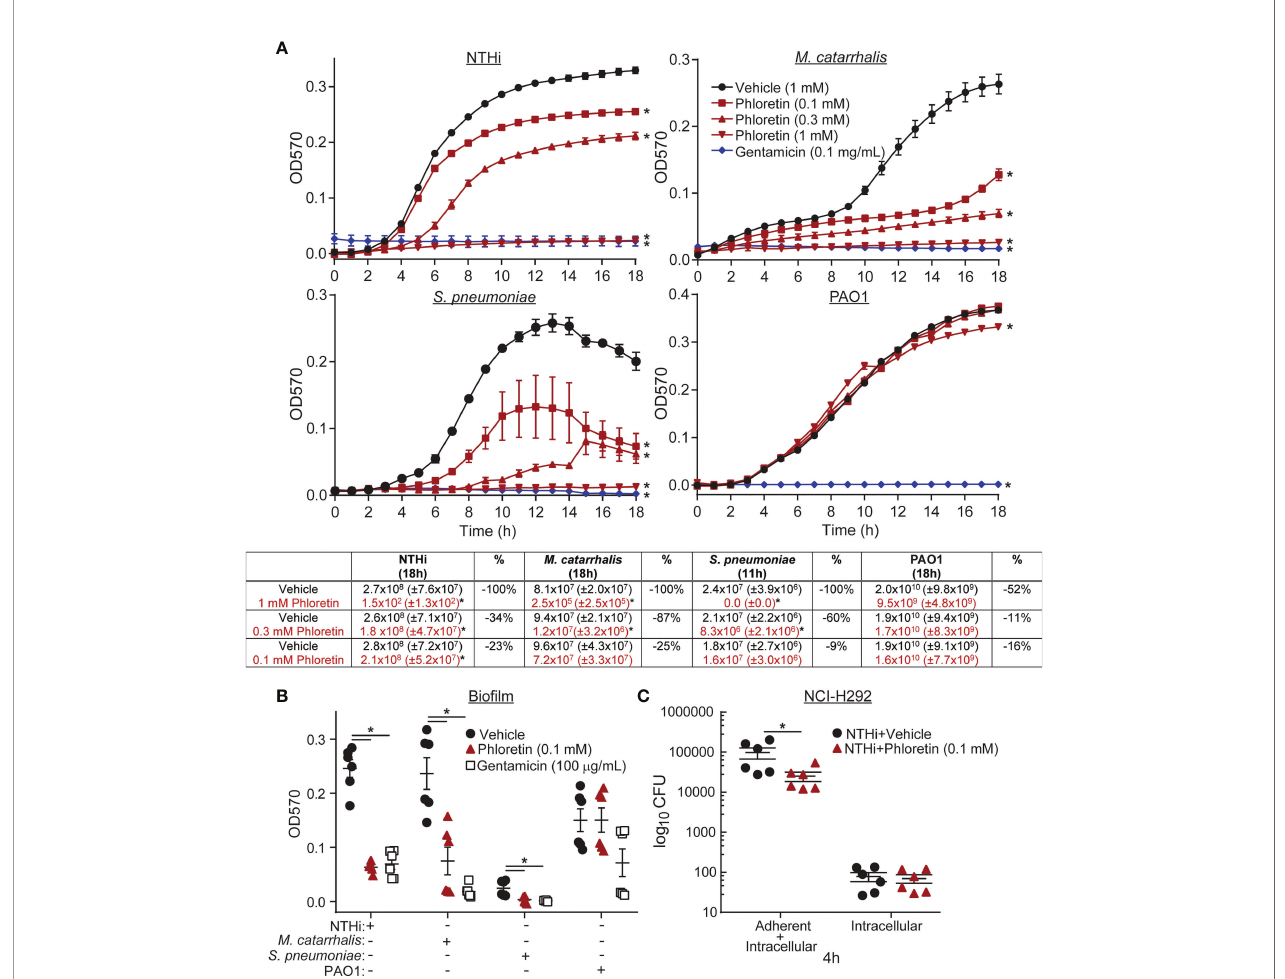
FIGURE 1 | Phloretin inhibits COPD pathogen growth and bio fi lm formation in abiotic assays and in coculture with lung epithelial cells. (A) Phloretin delays COPD pathogen growth in a dose dependent manner. (Graphs) 10 6 CFU nontypeable Haemophilus in fl uenzae (NTHi), 10 5 CFU Moraxella catarrhalis ( M. catarrhalis ), 5x10 5 CFU Streptococcus pneumoniae ( S. pneumoniae ), and 10 5 CFU Pseudomonas aeruginosa strain PAO1 were grown with vehicle, phloretin (0.1-1 mM), or gentamicin (100 µg/mL) at a 1:1 v/v over 18h. Bacterial growth was assessed by measuring the OD 570 hourly. *Signi fi cantly different